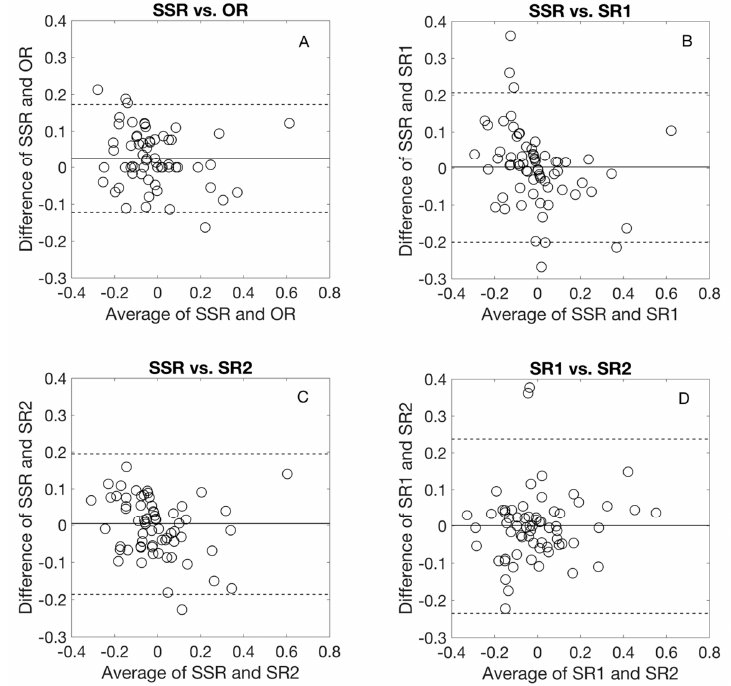
Figure 3. Bland-Altmann comparison for cylindrical component, J 45 among different refraction procedures. The middle line represents the average difference, the dashed lines represent 95% limits of agreement. OR: Objective refraction, SSR: Standard subjective refraction, SR1 and SR2: the two algorithm-based subjective refraction procedures.